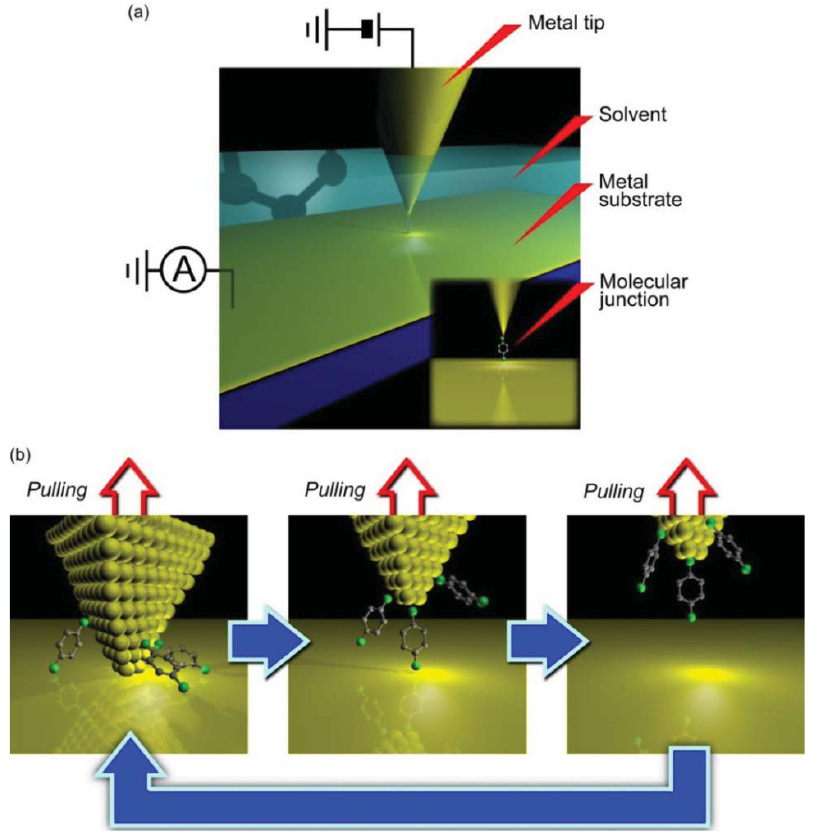
Figure 2. SPM break junction method. ( a ) The system consists of a metal substrate covered with self-assembled monolayer of a target molecule and a metal tip; ( b ) A tip is indented into a substrate in a solvent. Subsequently, the fused contact is stretched by pulling out the tip and the conductance trace is measured (left). In case of Au junctions, the conductance drops in a stepwise fashion and show a long plateau at 1 G formation of Au single atom chains. After breaking the Au contacts, current flows through several molecules bridging the tip and the substrate. Further retracting the tip, the metal-molecule bonds rupture and the number of the current-carrying molecules decreases one by one showing conductance staircases (middle) and finally to zero (right). Thousands of single-molecule junctions can be formed within a relatively short time by repeating the series of processes, which allows deduction of junction-to-junction variations of the single-molecule